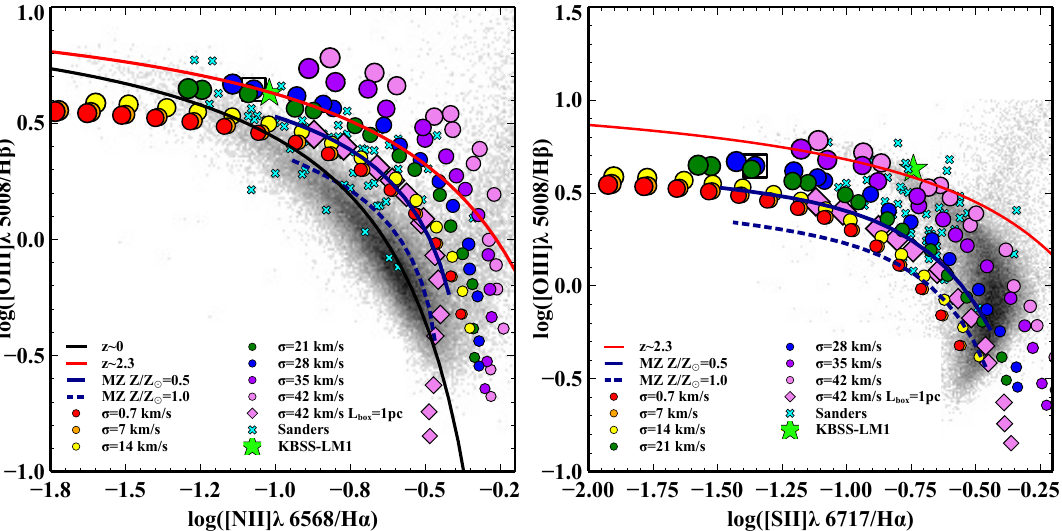
Figure 6. The effects of turbulence on the classic [N II] and [S II] BPT diagrams. These figures are as presented at the workshop, see [68] for more